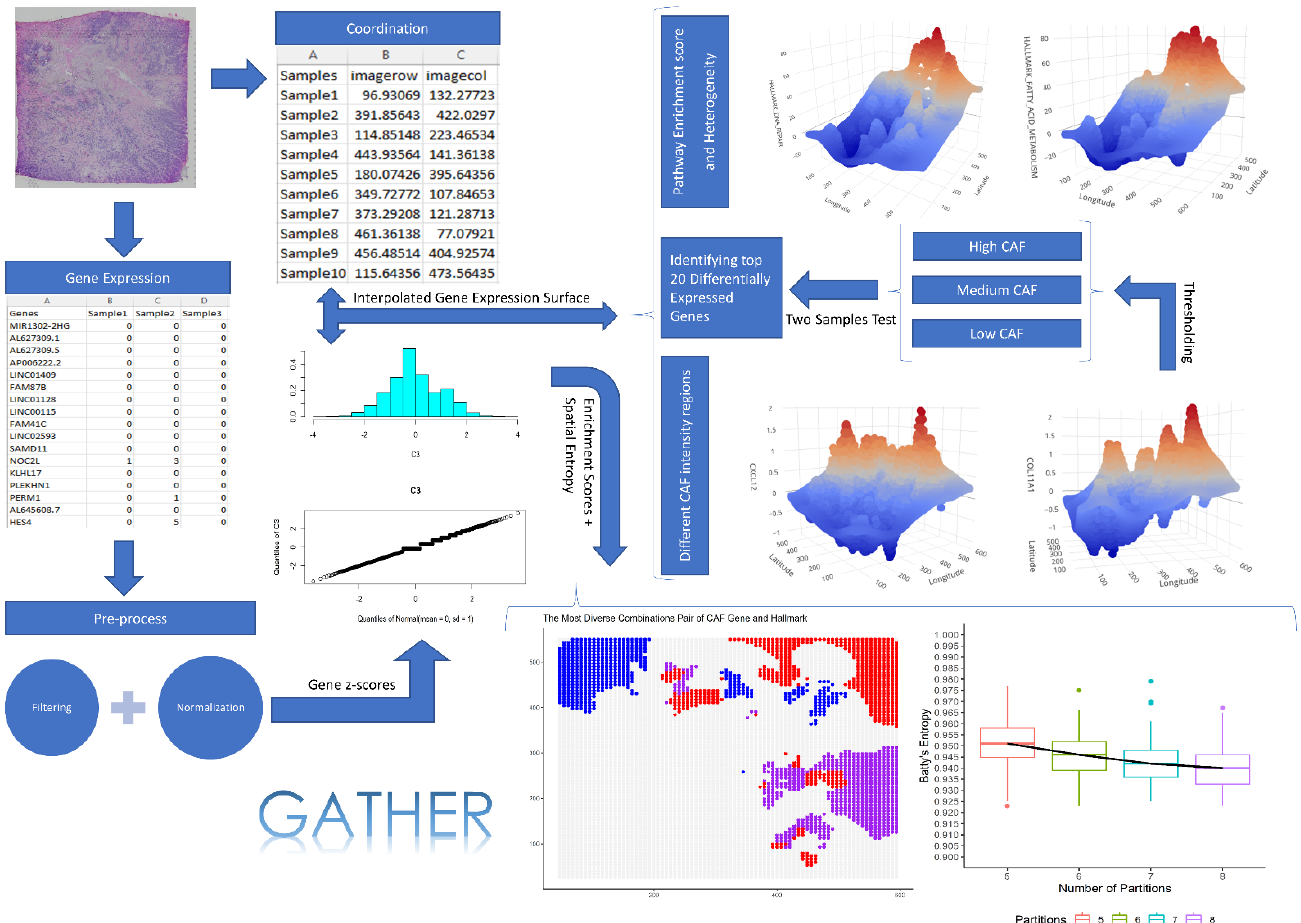
Figure 1. The GATHER workflow. It outlines the different analytical steps taken by GATHER starting from single-cell omics data preparation including normalization and filtering to the generation of kriging-predicted gene expression landscapes as well as iterative computation of spatial entropy measures. It also illustrates the interactive 3D visualization using GATHER of the computed gene- and gene set-specific landscapes defined over the input tissue